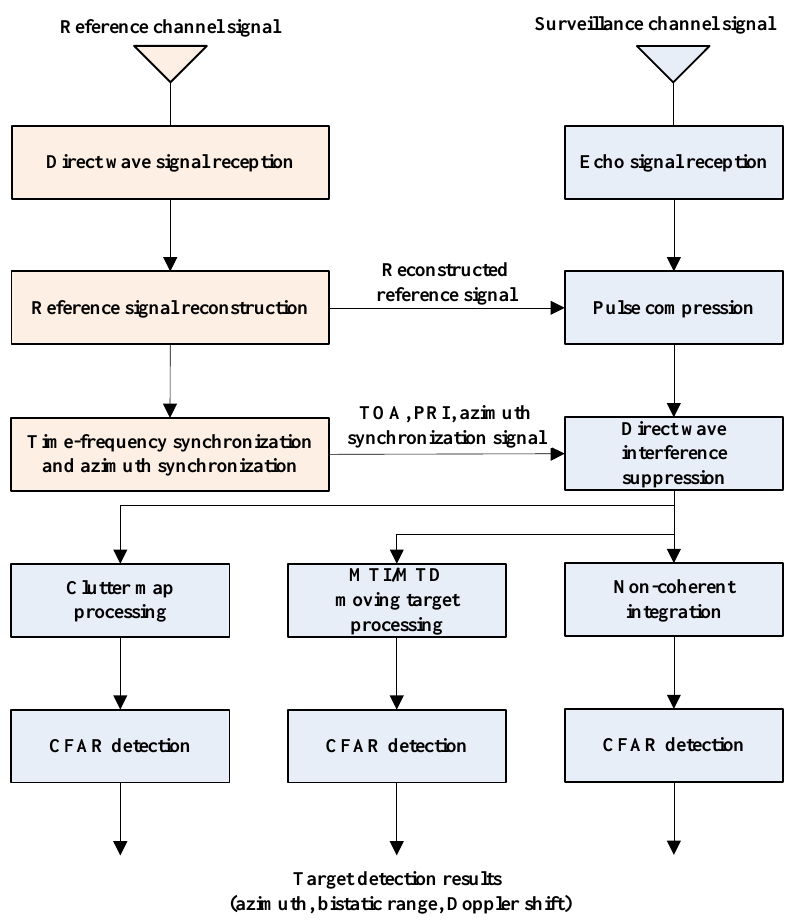
Figure 5. Signal processing flow chart of the HBR system.